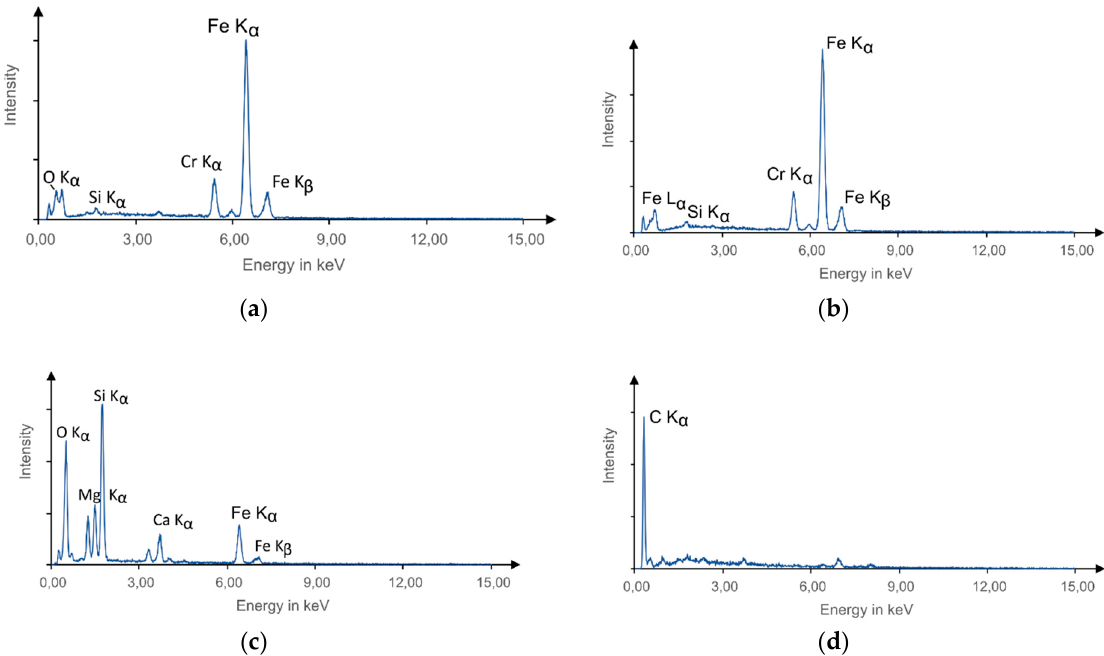
Figure 8. EDS spectra for the ( a – c ) selections 1–3 from Figure 7 as well as the undamaged coating ( d ).